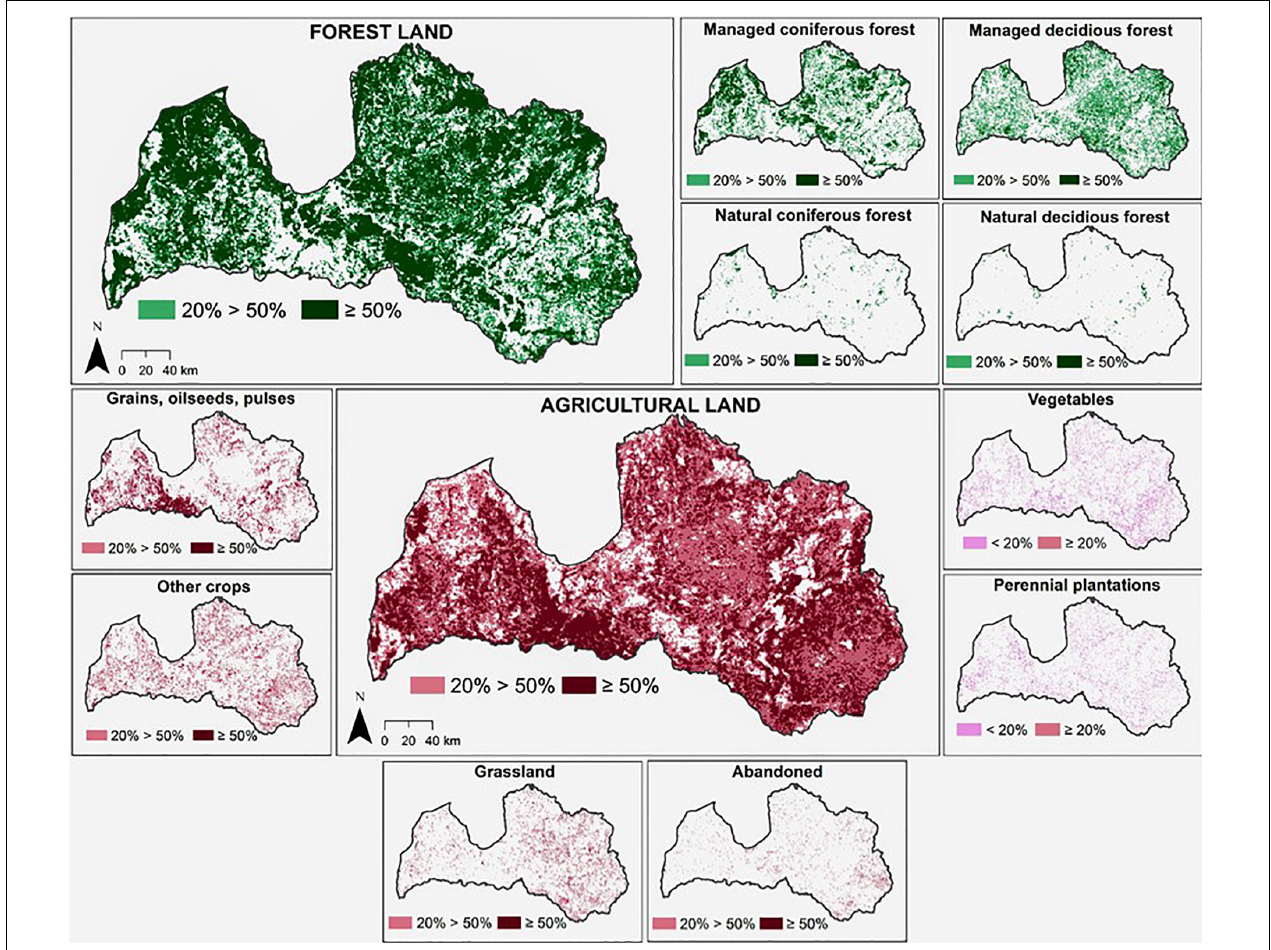
FIGURE 5 | Indicative land use map of Latvia. The percentages indicate proportional land use. For example, where forest land exceeds 50%, it means that at least 50% of the hexagon area is forested (similar to O’Sullivan et al., 2015,